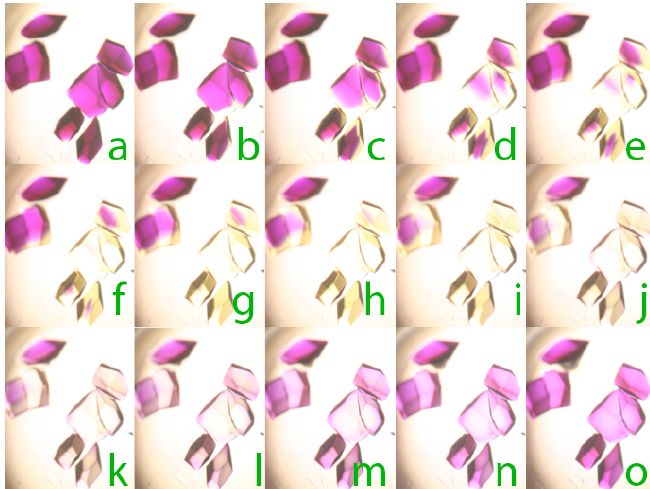
Figure 8. Lysozyme crystals were saturated with the dye crystal violet ( a ) and dithionite added to the mother liquor in ( b ). The purple color was progressively lost as the dye was reduced. At ( k ), however, oxygen from the environment competed to re-oxidize the dye, which then experienced a second cycle of reduction in ( n ) and ( o ). The series of images ( a – o ), taken at appropriate time intervals, shows the progress of the dye.